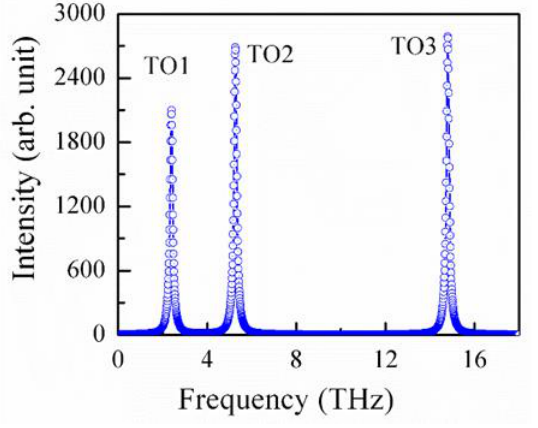
Figure 10. Calculated IR active TO mode frequencies of BZO crystals in the cubic